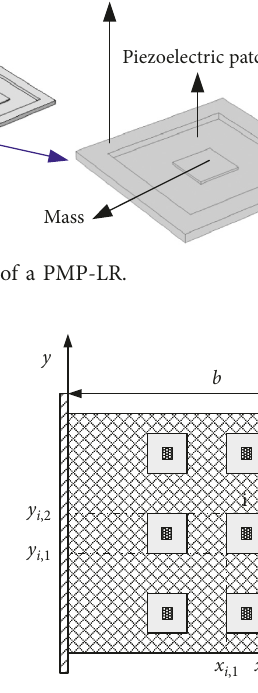
Figure 2: Geometrical dimensions of the